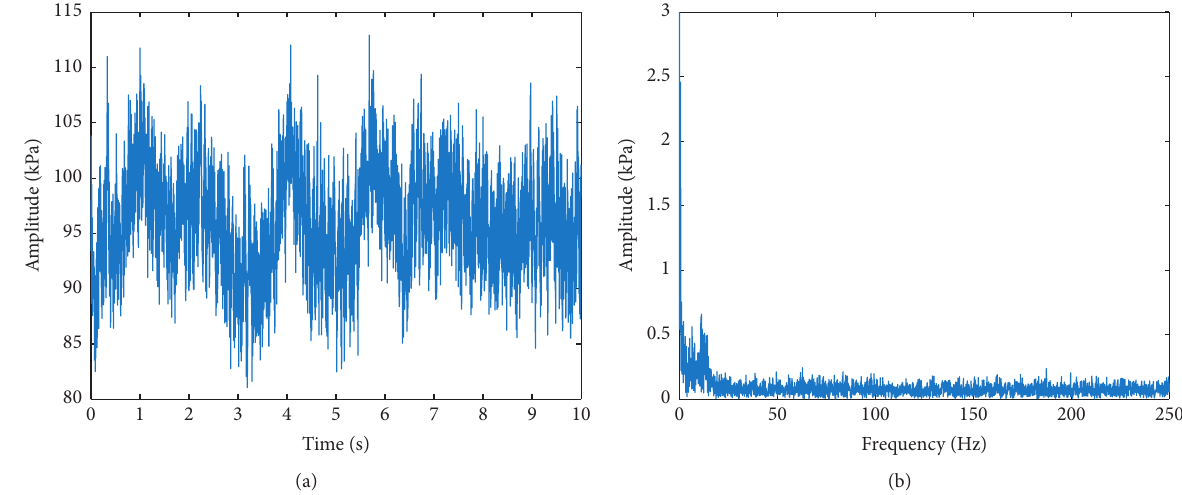
Figure 8: Waveform and spectrum diagram of the draft tube. (a) Waveform diagram. (b)